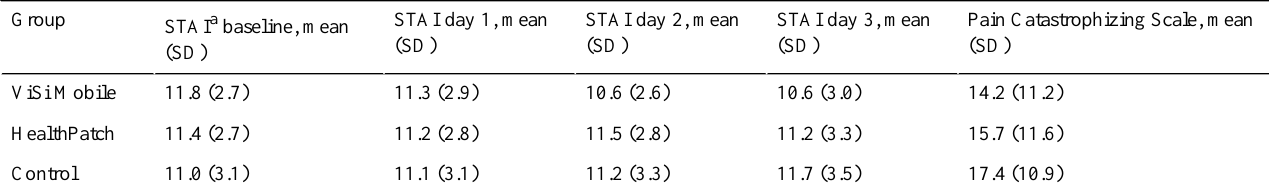
Table 2. State Trait Anxiety Inventory and Pain Catastrophizing